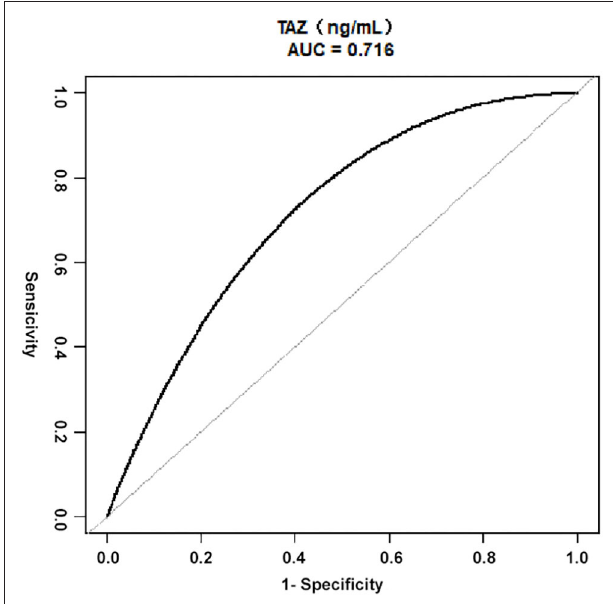
FIGURE 3 | ROC curves for the preoperative plasma level of TAZ in ATAAD, using Bootstrap resampling (times = 500) for the association of postoperative in-hospital mortality. AUC confidence interval and significance tests using Bootstrap resampling. The best threshold was based on maximizing the sum of sensitivity and specificity. The analysis reveals that 12.70 (ng/mL) was the best threshold (AUC: 0.72, 95% CI 0.53–0.86; sensitivity: 68.60%; specificity: 77.78%). ATAAD, Acute type A aortic dissection; ROC, receiver-operating characteristic; AUC, area under the curve; CI, confidence interval; TAZ, WW domain–containing transcription regulator protein